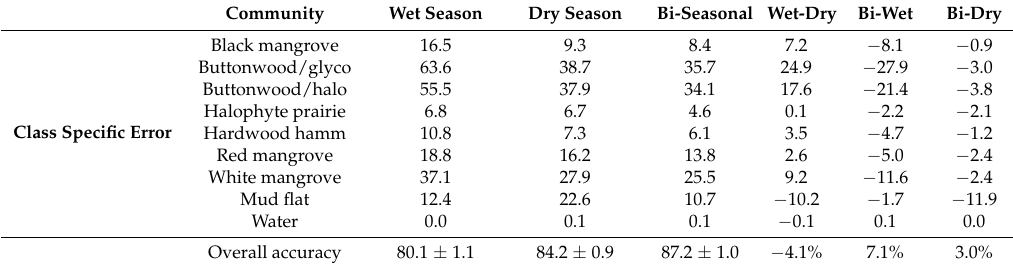
Table 2. WorldView-2 random forest classifier models evaluated for the wet season, dry season, and both the wet and dry seasons combined (bi-seasonal) to determine which model would produce the most accurate classification for each community type. Numbers are the percent omission error for each class within each classified model. Columns Wet-Dry, Bi-Wet, and Bi-Dry give the difference in percent error between models for each community; the smaller the absolute value of the number, the more similar those models classified that community type. If a number is positive, the second model in the pair was better (smaller error), while if a number is negative, the first model was better. Overall percent accuracy and standard deviation for each model are given at the bottom. Community types are described in the text: Buttonwood/glyco = Buttonwood/glycophyte; Buttonwood/halo = Buttonwood/halophyte; Hardwood hamm = Hardwood hammock. Community Wet Season Dry Season Bi-Seasonal Wet-Dry Bi-Wet